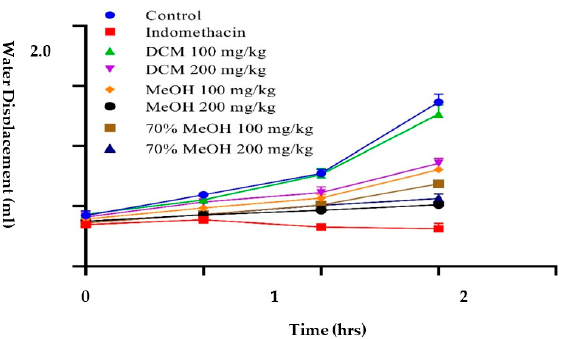
Figure 3. Inhibition against carrageenan-induced paw edema by Peganum harmala sequential crude extracts.